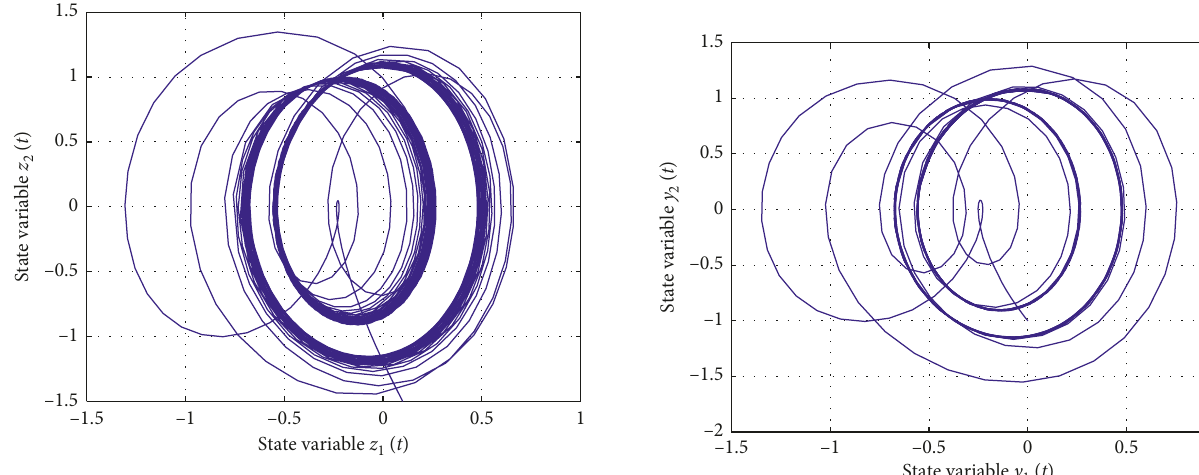
Figure 3: The simulation result for the slave system with k � 2 . 98 ,k � 0 , and k � 2 . 98. 1 2 3